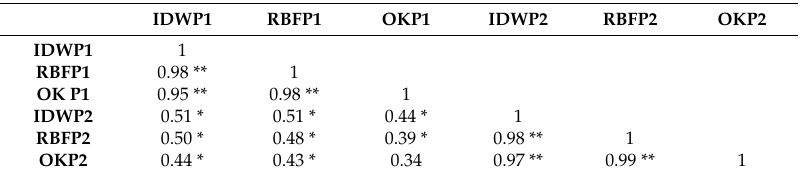
Table 6. Pearson correlation coefficients, n † = 26.